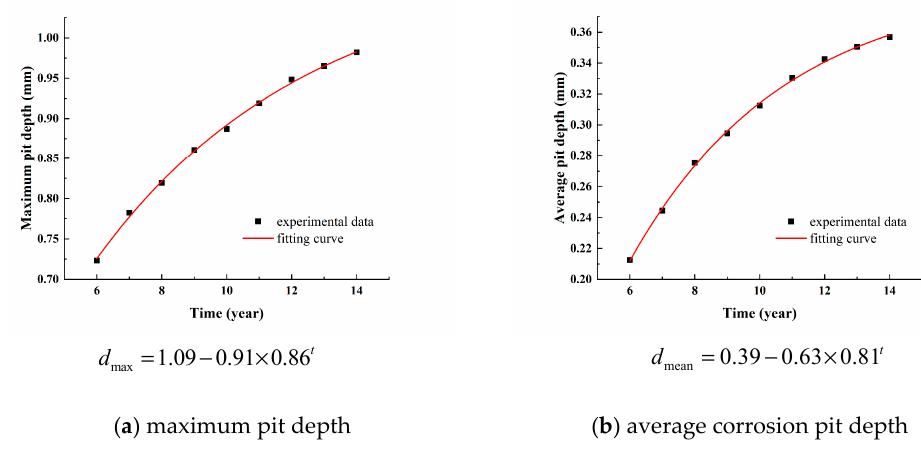
Figure 4. Time-varying fitting curve of the corrosion pit width.